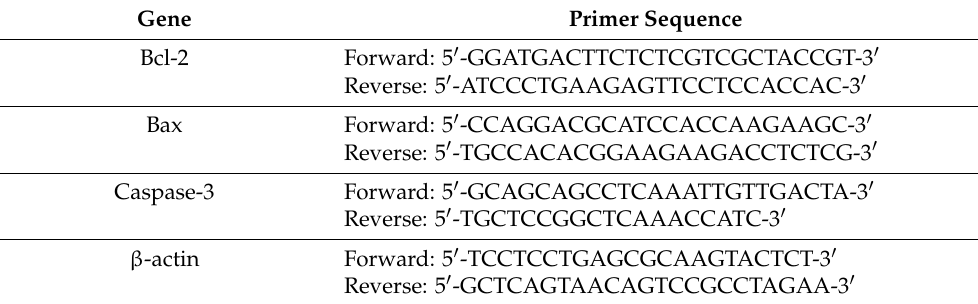
Table 1. Primers sequence for Bcl-2, Bax, caspase-3 and β